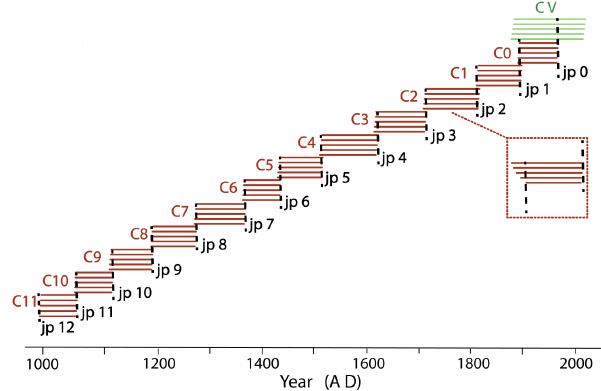
Figure 2. Illustration of the sampling strategy. From year 1000 to 2006, cohorts are represented in red for subfossil stem segments (C0-C11), and in green for living trees (CV). The join points are in black on the overlapping periods (JP0 to